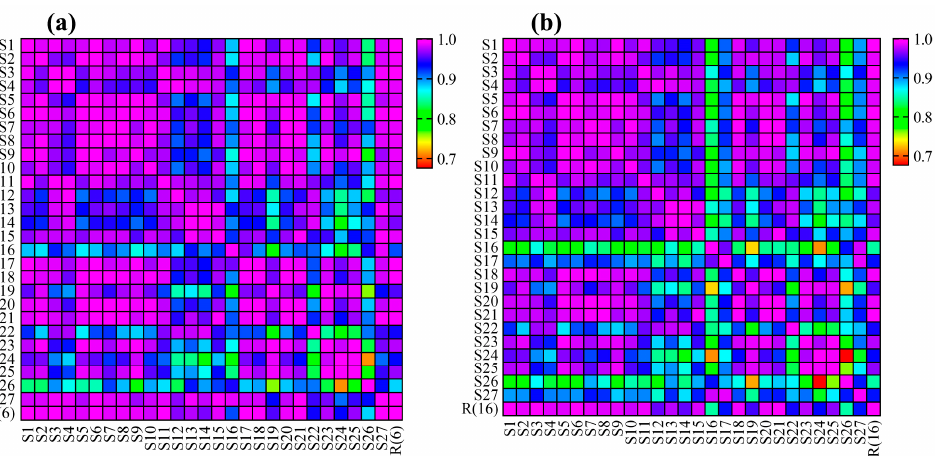
Figure 6. The heat maps of fingerprint similarity data matrices. ( a ) The heat map of method one and ( b ) The heat map of method two.